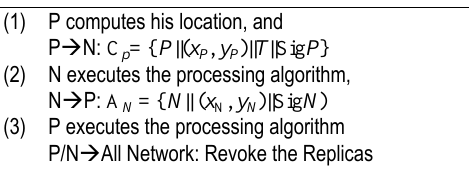
Figure 1. Basic frame patrol detection